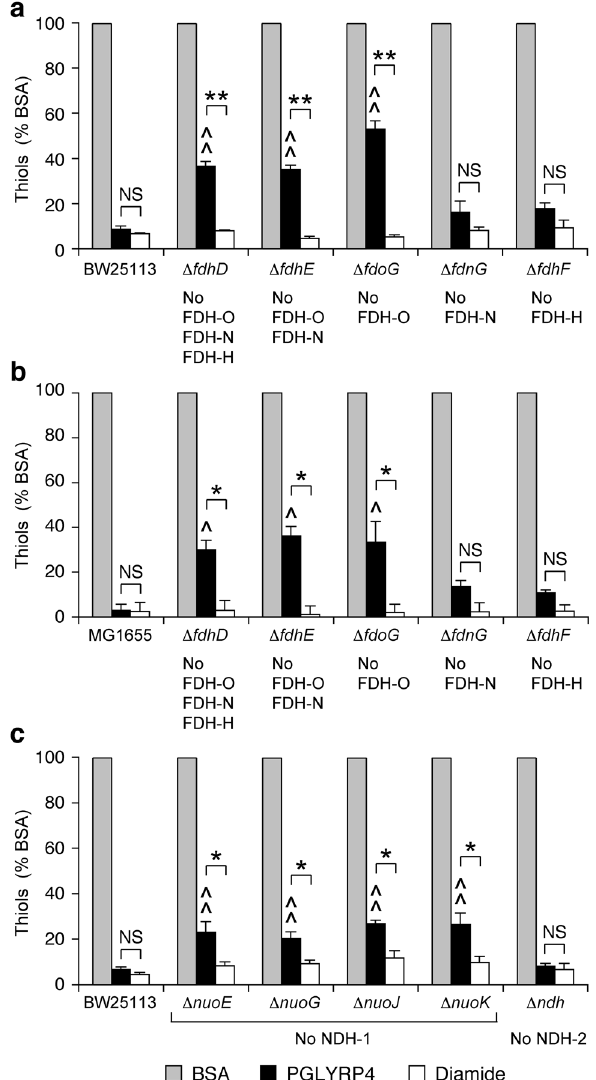
Figure 8. Deletion of FDH or NDH-1 in E. coli attenuates PGLYRP4-induced thiol depletion. The results are the amounts of thiols expressed as percent of control with BSA (100%) and are means ± SEM from 3 to 4 experiments (biological replicates); ^ P < 0.05, ^^ P < 0.001 mutant vs parental strain; NS not significant ( P > 0.05); * P < 0.05, ** P < 0.001 as indicated by brackets. FDH-O, FDH-N, and FDH-H—formate dehydrogenase O, N, and H (respectively); NDH-1 and NDH-2—NADH dehydrogenase I and II